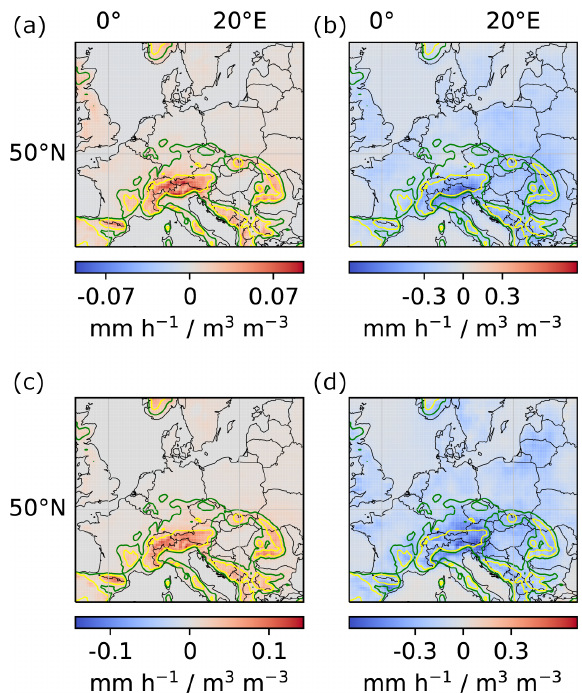
Figure A3. Local and regional soil-moisture–precipitation cou- plings for models trained on the left and right half of the considered region, respectively. (a, c) Local couplings. (b, d) Regional cou- plings. (a, b) Model trained on the left half of the considered region. (c, d) Model trained on the right half of the considered region (see Appendix Fig. A4). Note that the models were trained only on the left and right half, respectively, but the model architecture allows us to compute local and regional couplings for the entire region.